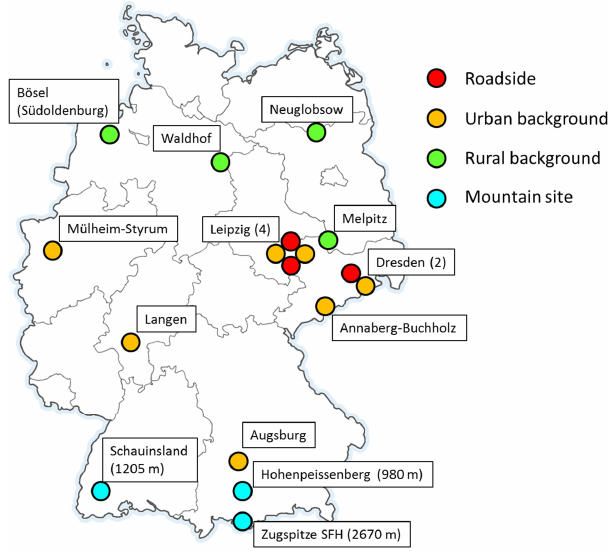
Figure 1. Location of the atmospheric observation sites in the Ger- man Ultrafine Aerosol Network (GUAN), currently consisting of 17 sites. See Table 1 for the full names and characteristics of the